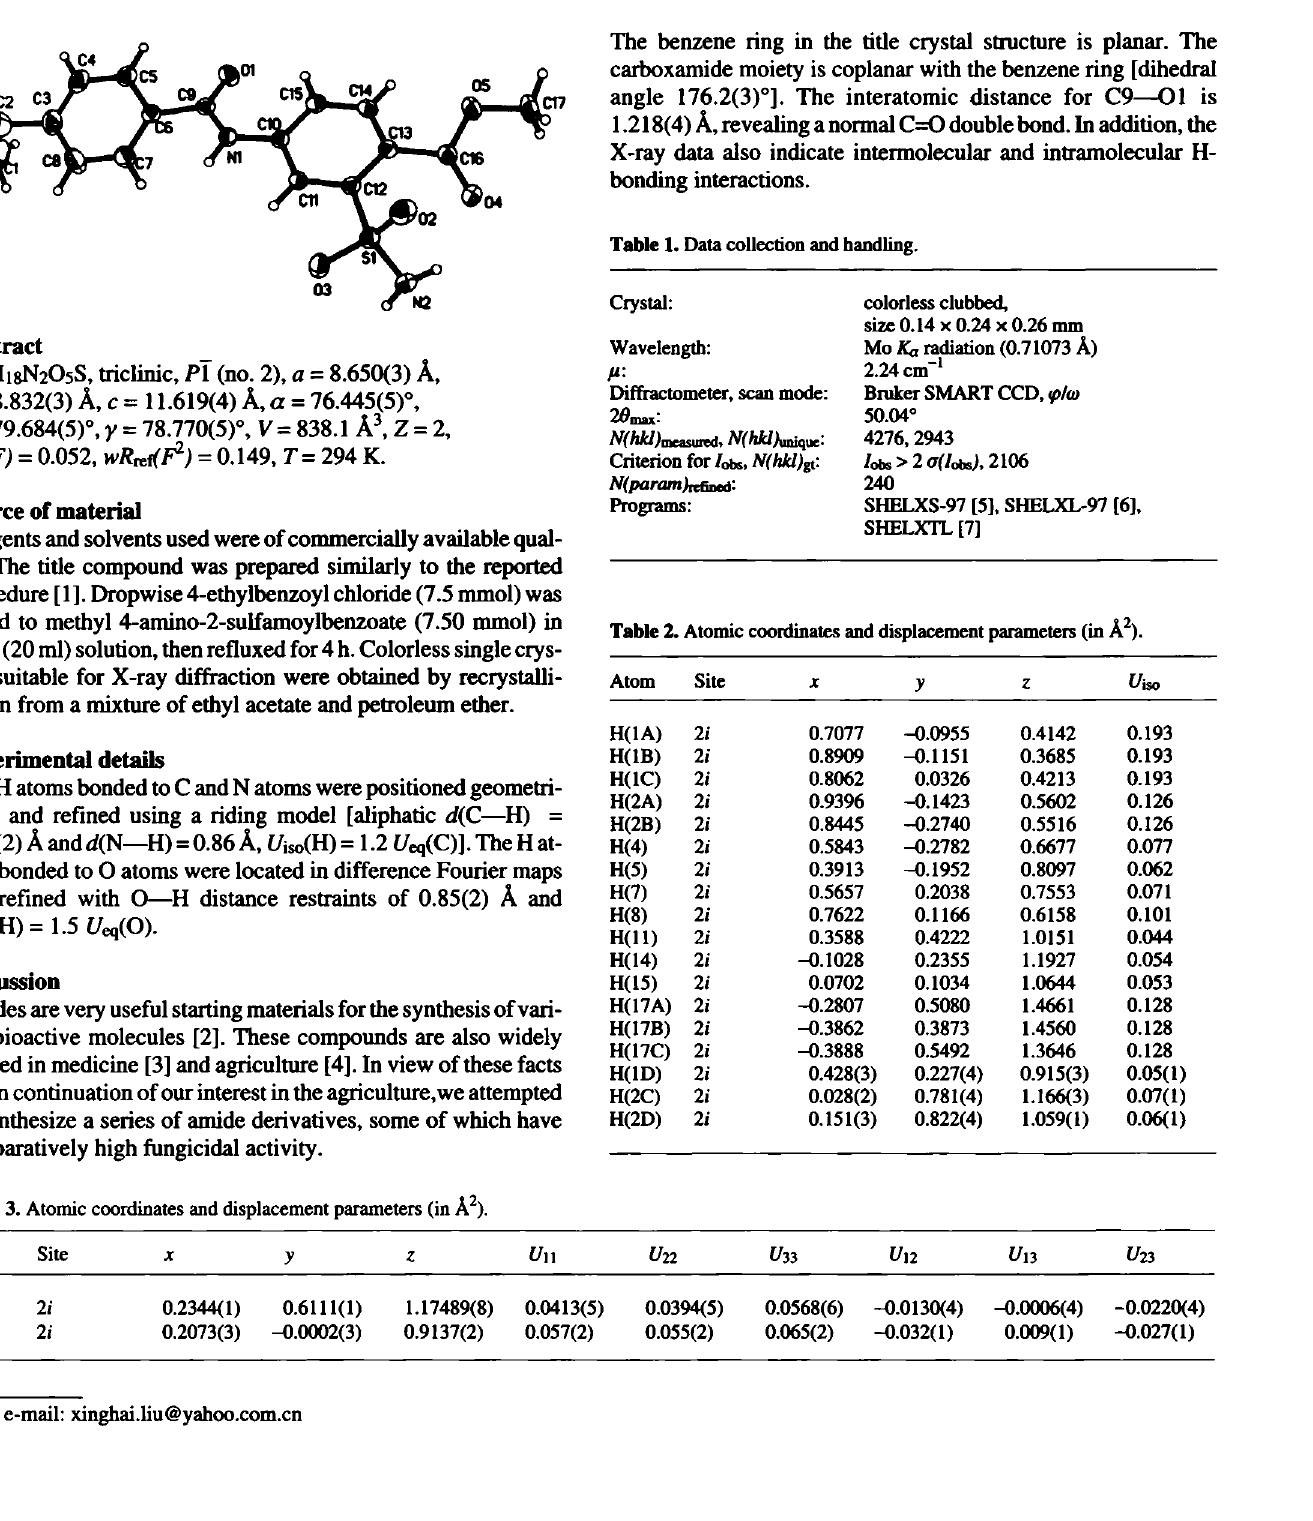
Table 1. Data collection and handling.